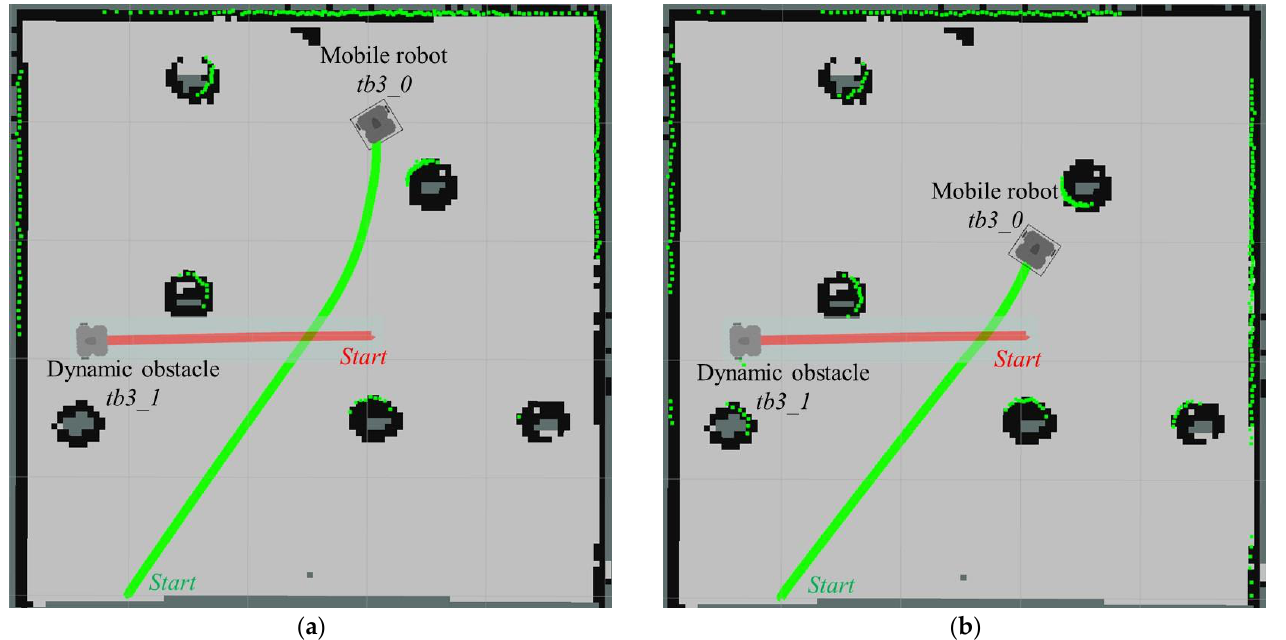
Figure 17. ( a ) Rviz simulation for dynamic environment scenario 2 after testing the LSTM model with goal point of (3.0, 4.0) for 𝑡𝑏3_0 , ( b ) Rviz simulation for dynamic environment scenario 2 after testing LSTM model with goal point of (3.0, 3.0) for 𝑡𝑏3_0 .